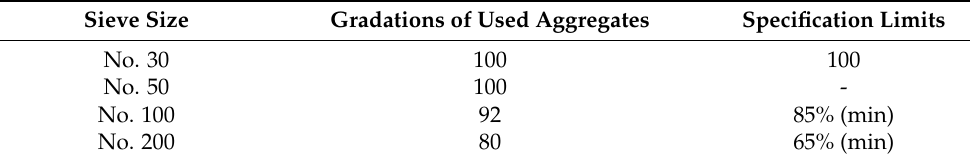
Table 5. The gradation of mineral filler.